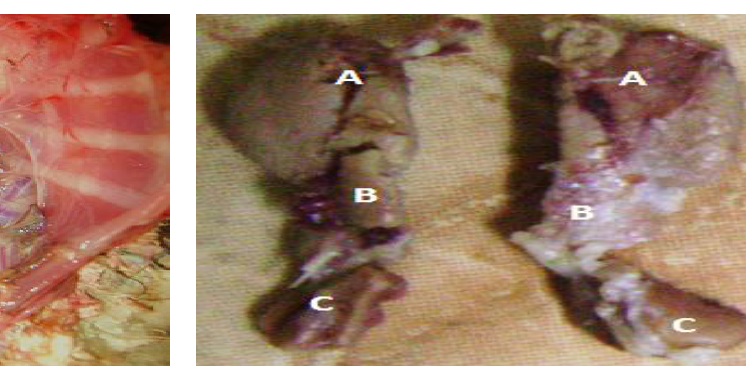
Figure, 1: Anatomical specimen of Harrier shows: (A) kidneys cranial lobe, (B) Kidneys middle lobe, (C) Kidneys caudal lobe, (D) Left ovary, (E) Lungs.